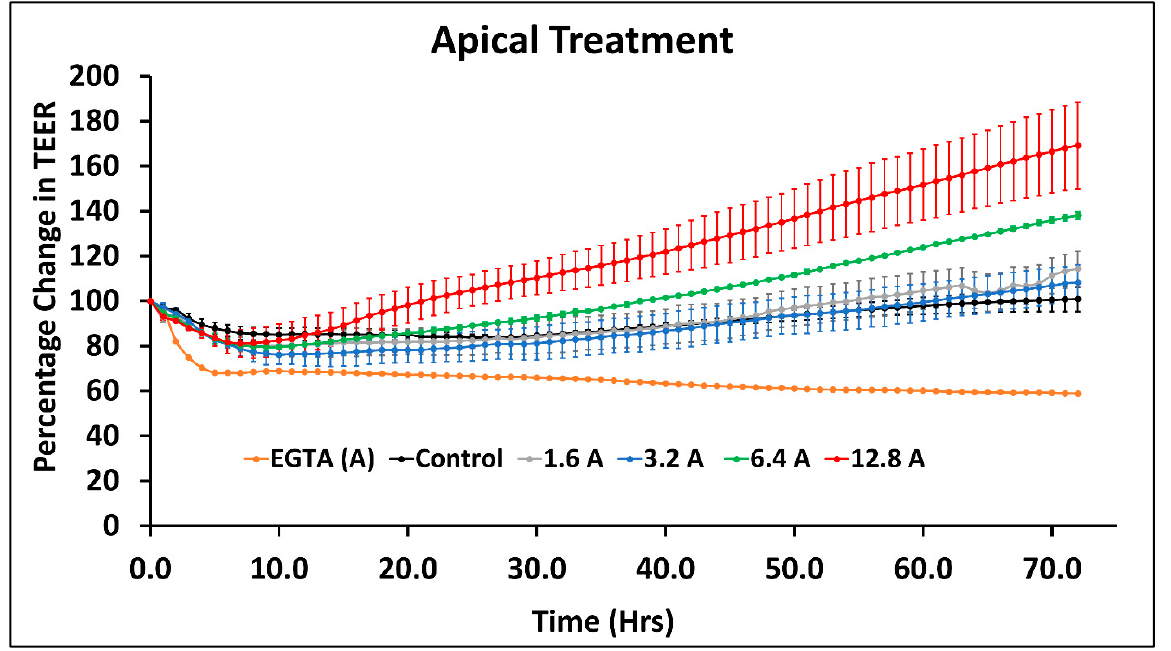
Figure 2. Change in TEER of T-84 cells monolayers during exposure to sodium arsenite from the apical side. A in legend denotes treatment from apical side with 1.6, 3.2, 6.4 and 12.8 µM concentrations. In addition, 2 mM of EGTA apical treatment was used as positive control. The graph represents the mean ± SD for each treatment group.